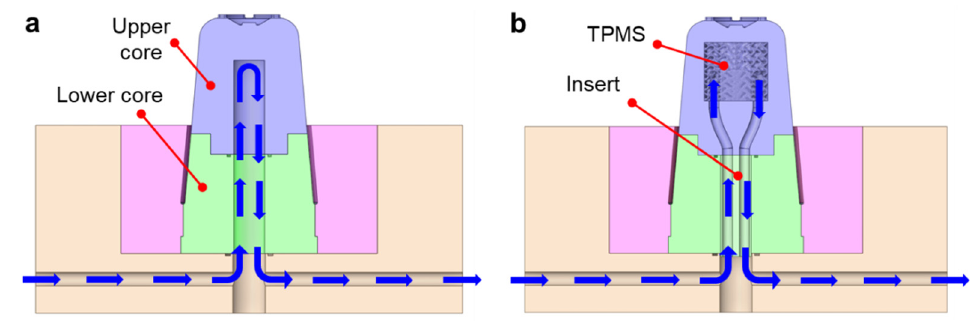
Figure 5. Sectional configurations of the mold cores with different cooling structures: ( a ) Baffle cooling. ( b ) TPMS